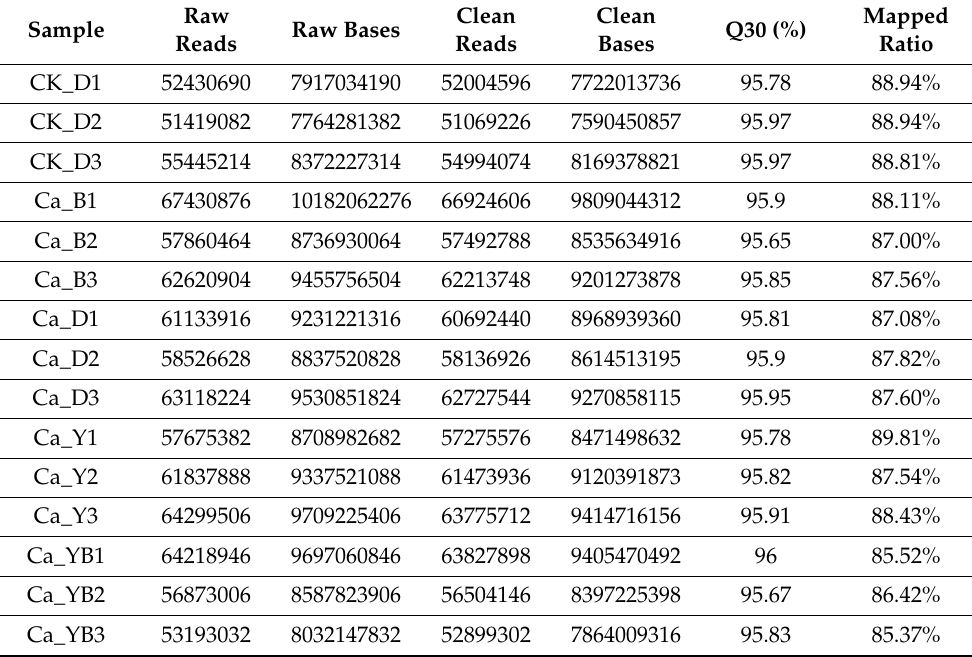
Figure 4. Detection of MDA ( A ), GPx ( B ), SOD ( C ), and CAT activity ( D ). CK-Y, CK-D, and CK-YB represented the no mental ion-treated group with yellow, dark, and yellow–blue shift light, respectively. Ca-Y, Ca-D, and Ca-YB represented the Ca 2+ -treated group with yellow, dark, and yellow–blue shift light, respectively. Table 1. The reads, bases number, and mapping rate of the A. sinodeliciosus